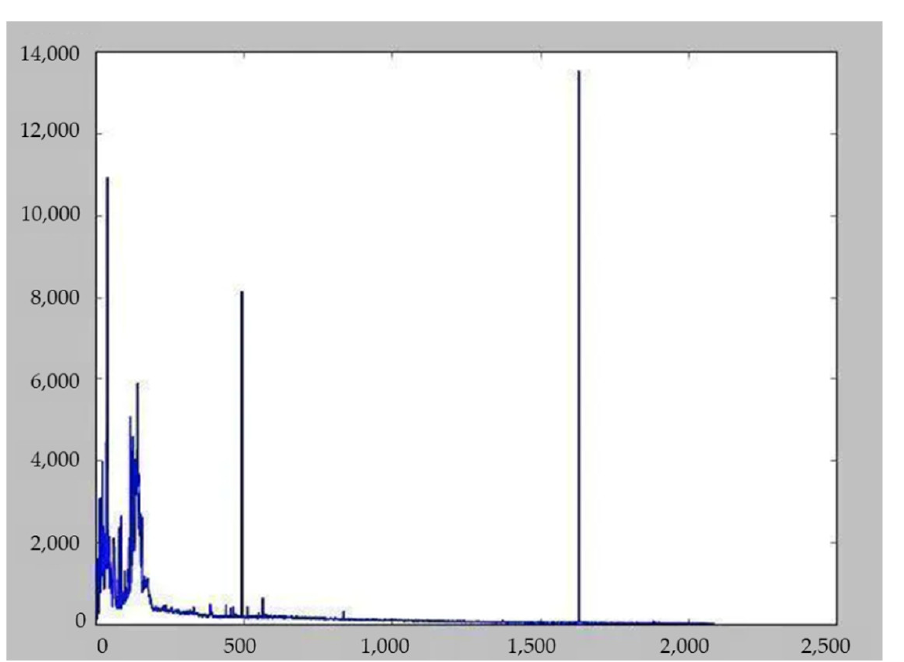
Figure 3. Text length distribution of Sohu News dataset.